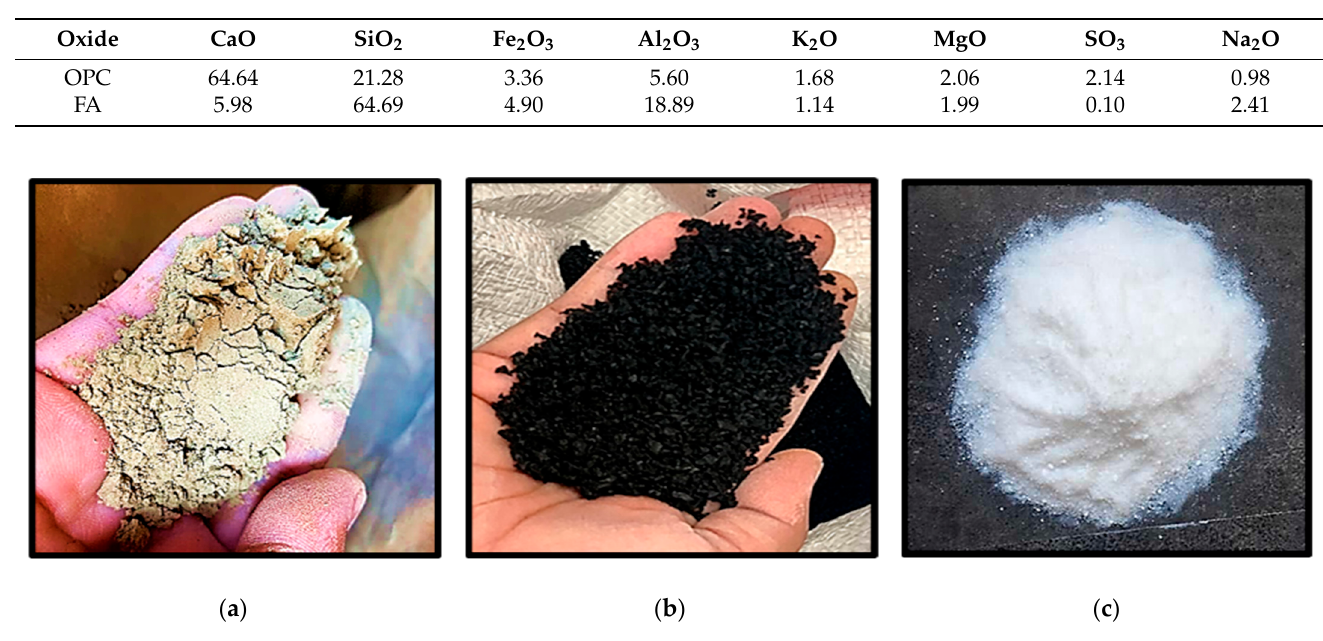
Figure 2. The materials used as the RSM input factors. ( a ) Class fly ash; ( b ) crumb rubber, and ( c ) nanosilica.